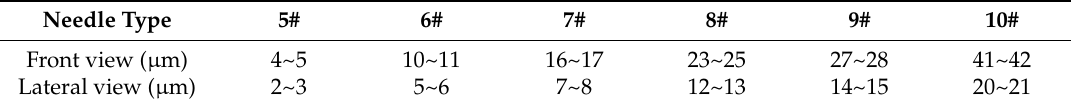
Table 1. Values of needle tip curvatures from the front and lateral